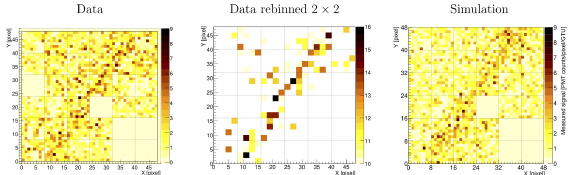
Figure 2. Example of a UHECR observed by EUSO-TA (E ∼ 10 18 eV, impact parameter 2.5 km with respect to the telescope, zenith angle of the axis of 35 ◦ and azimuth angle of 7 ◦ ) with dif- ferent pixel binning and comparison with simulations. The left plot shows the real data in photoelectron counts, in the centre 2 × 2 rebinning of the data is shown and in the right plot the simulation made with the O ff Line package [13].